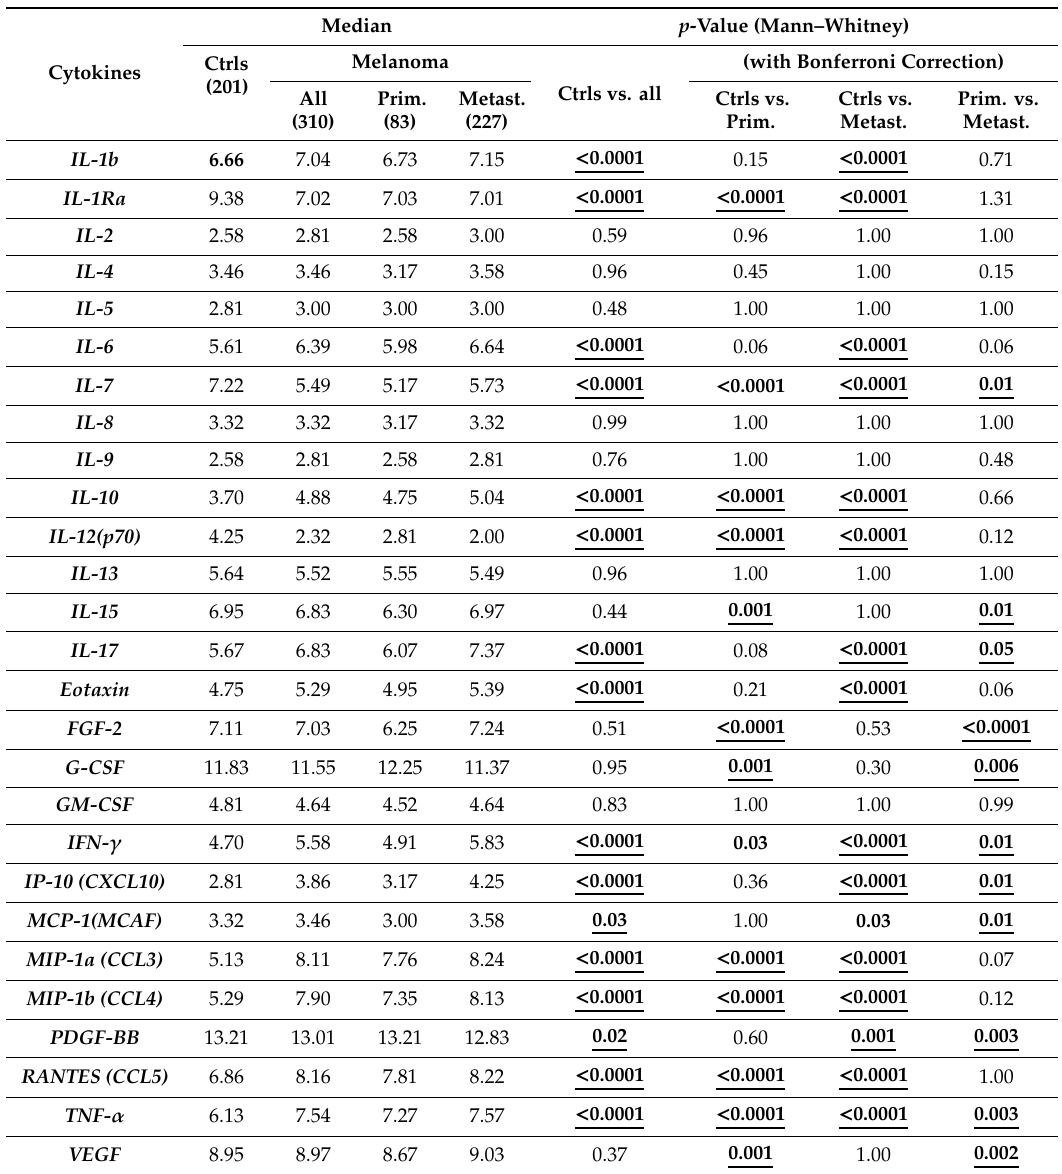
Table 8. Tissue expression: medians of the expression values of the 27 chemokines / cytokines for the control and for melanoma patients (all, primary, and metastatic). The table also reports the significance of the di ff erence according to Mann–Whitney analyses (Wilcoxon two-sample rank-sum test): for p -values < 0.05 the null hypothesis (i.e., the corresponding sets of samples have the same median) should be rejected (values in bold and